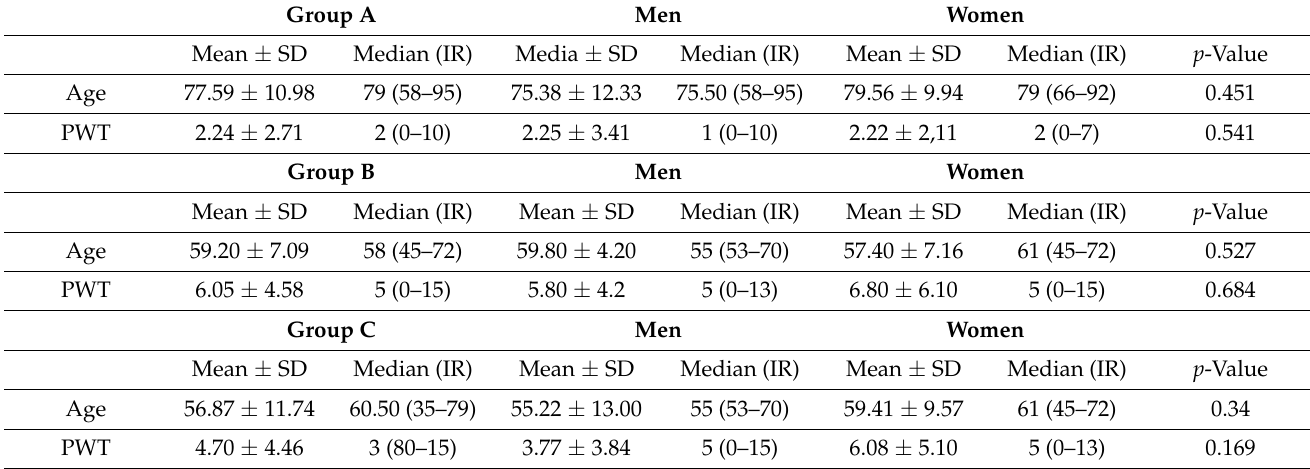
Table 3. Group A, B and C